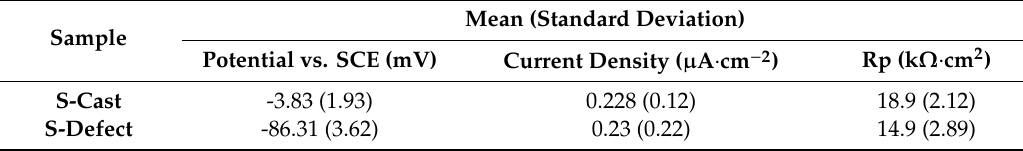
Table 5. Corrosion parameters of S-Cast and S-Defect.